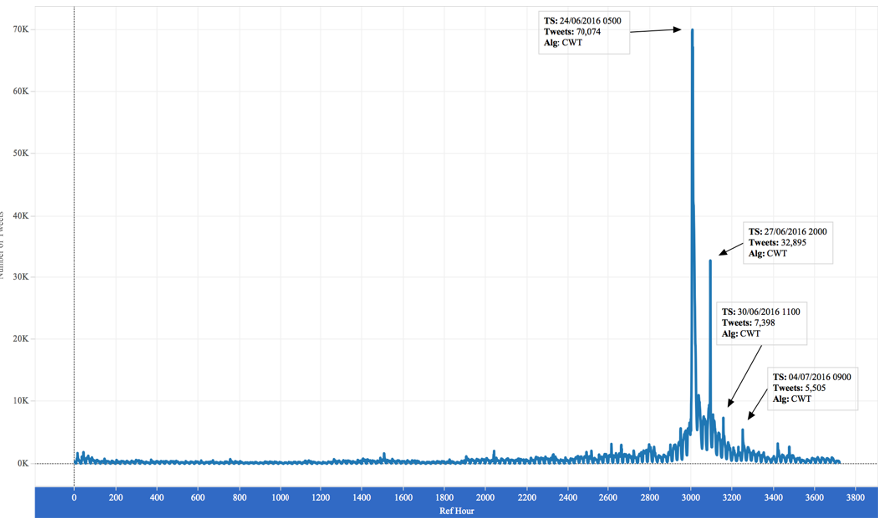
Figure 3. True Peaks Detected.